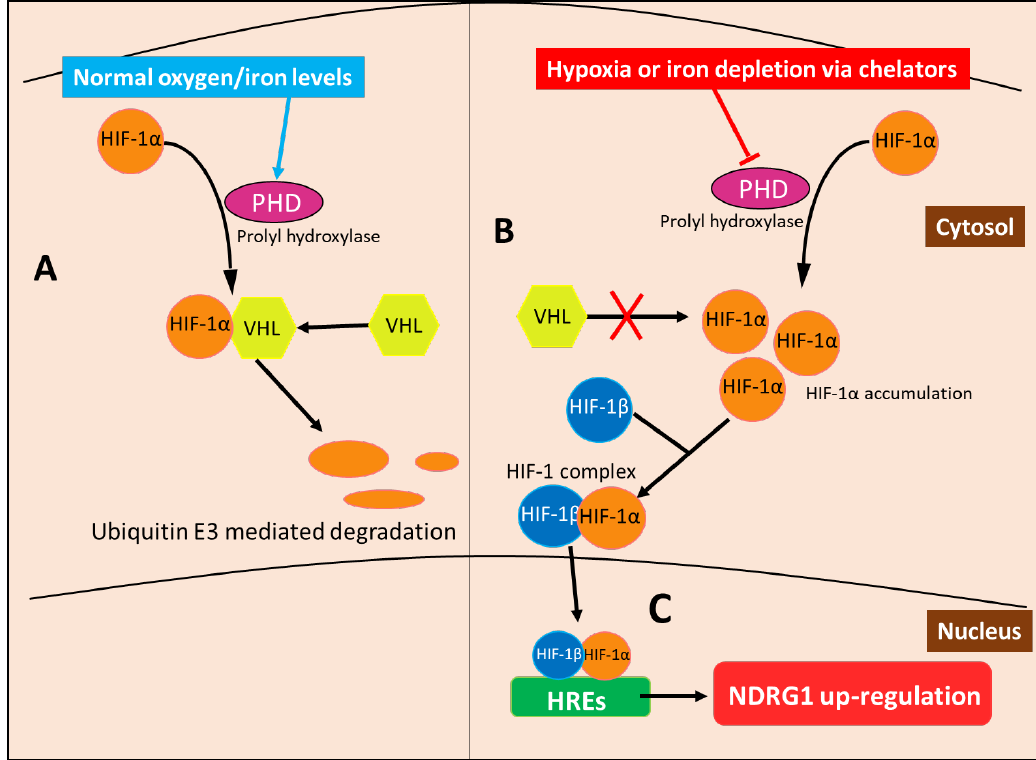
Figure 9. Metal-binding ligands such as DFO induce NDRG1 expression via HIF-1 α accumulation. ( A ) Normal oxygen and iron levels enable prolyl hydroxylase (PHD) to hydroxylate HIF-1 α , creating a binding site for von Hippel-Lindau (VHL) protein to bind HIF-1 α and activate ubiquitin E3 ligase, resulting in the proteasomal degradation of HIF-1 α . ( B ) In contrast, during hypoxia or when metal-binding ligands deplete cellular iron, the PHD enzyme is inactivated and does not hydroxylate HIF-1 α , preventing the binding of VHL. This mechanism prevents HIF-1 α degradation, which consequently accumulates and forms the HIF-1 complex by binding to HIF-1 β . ( C ) The HIF-1 complex then translocates to the nucleus and binds the hypoxia-response elements (HREs) located in the NDRG1 promoter, thus up-regulating its